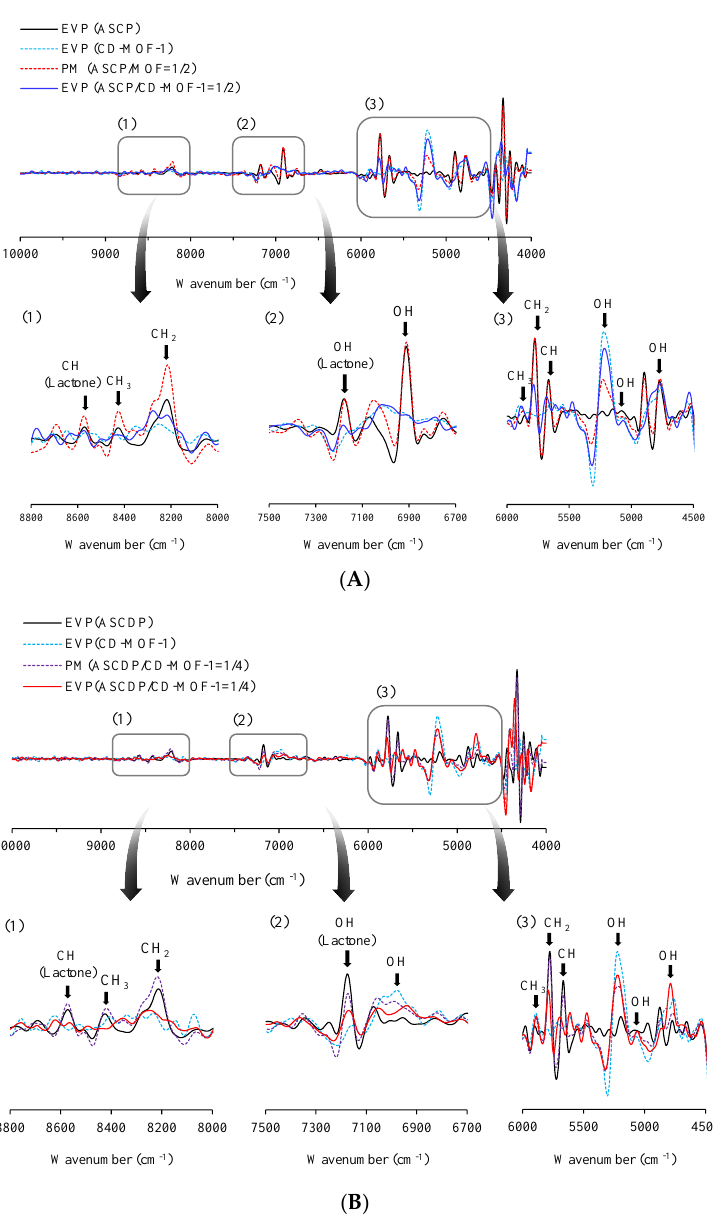
Figure 4. ( A ) Second differentiation NIR absorption spectra of ASCP/CD-MOF-1 systems: ( 1 ) 8800 – 8000 cm −1 ; ( 2 ) 7500 – 6700 cm −1 ; ( 3 ) 6000 – 4500 cm −1 . ( B ) Second differentiation NIR absorption spectra of ASCDP/CD-MOF-1 systems: ( 1 ) 8800 – 8000 cm −1 ; ( 2 ) 7500 – 6700 cm −1 ; ( 3 ) 6000 – 4500 cm −1 .